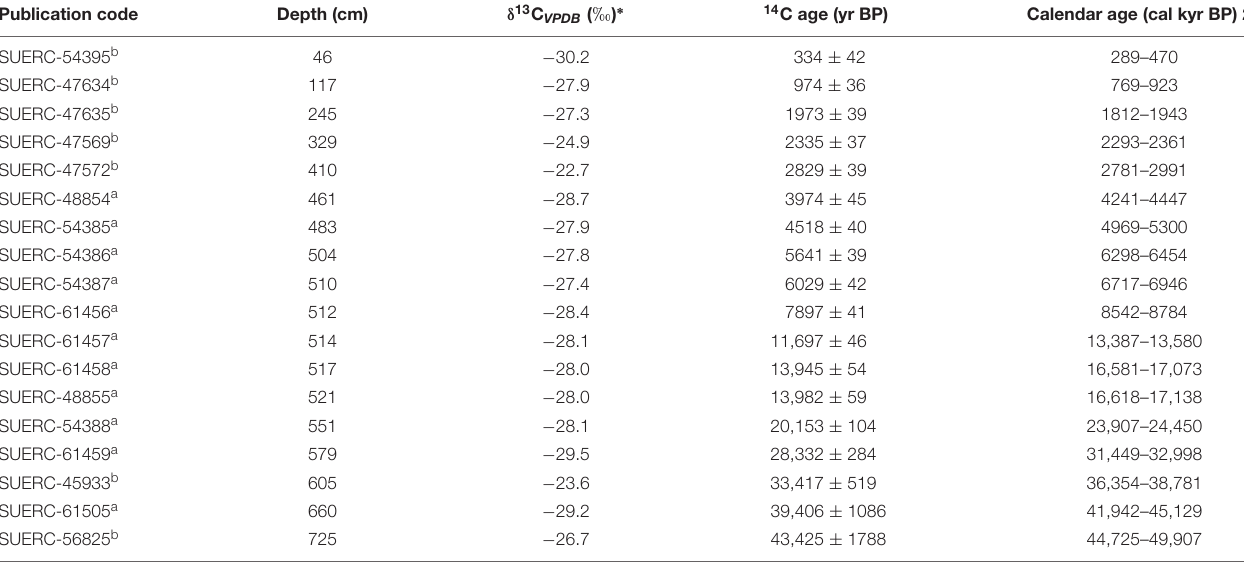
TABLE 2 | Conventional (yr BP) and calibrated (cal kyr BP) radiocarbon data used in construction of chronologies for Laguna